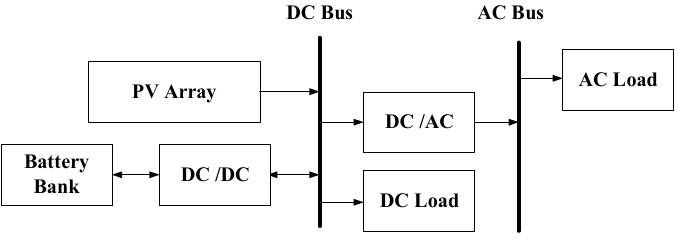
Figure 4. Block diagram of autonomous hybrid PV/battery storage system.